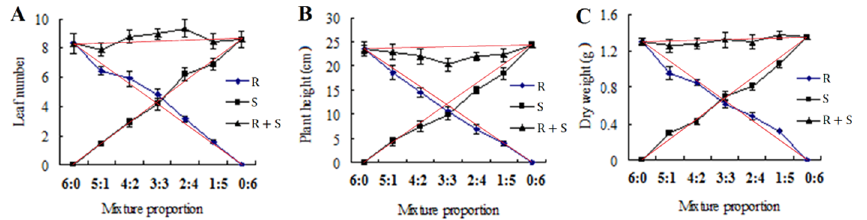
Figure 3. Replacement series diagrams for ( A ) leaf number, ( B ) plant height, and ( C ) dry weight of resistant and susceptible biotypes at 42 DAT. Red lines indicate the hypothetical values for ALS- resistant and ALS-susceptible biotypes with equal competitiveness. Bars represent standard error.